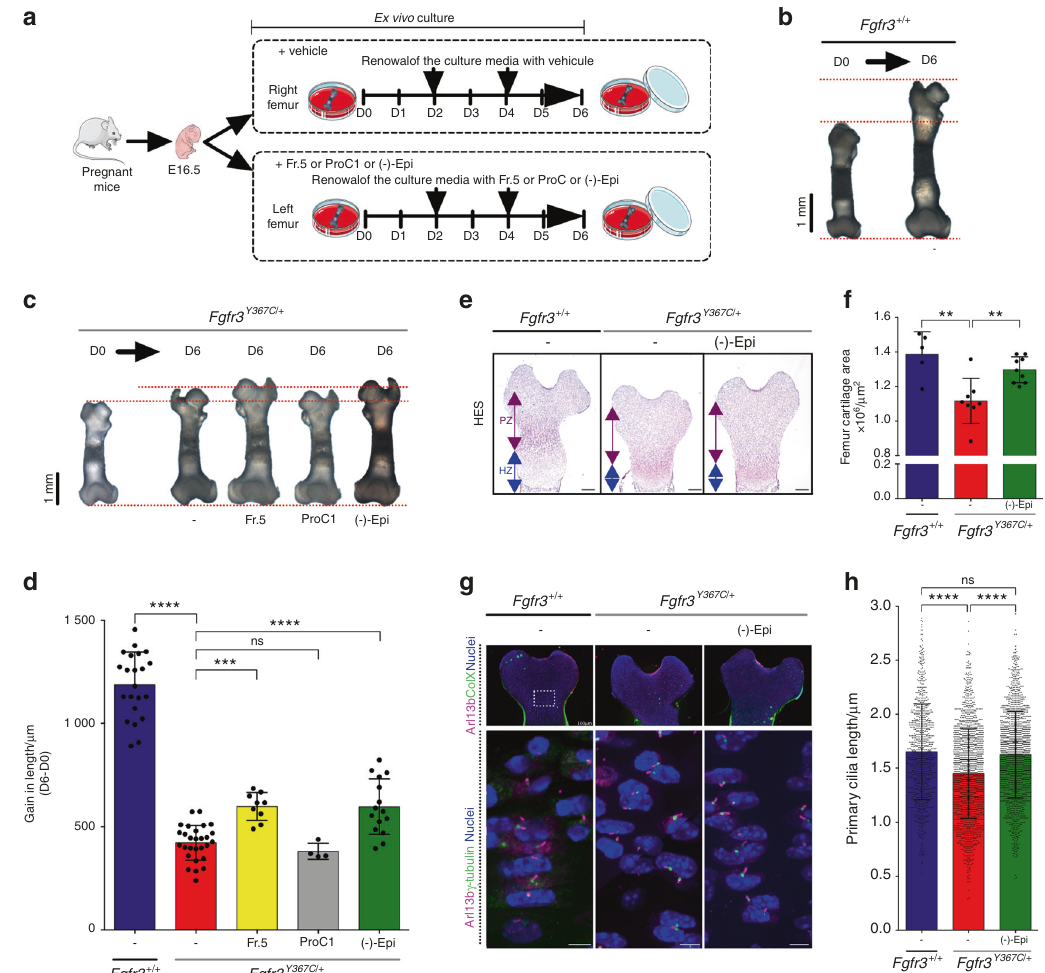
Fig. 3 (-)-Epicatechin increases ex vivo Fgfr3 Y367C/ + femur growth through primary cilia elongation. a Sequential representation of the ex vivo culture of femurs isolated from mouse embryos (E16.5). b Representative images of E16.5 Fgfr3 + / + femurs in ex vivo culture for 0 (D0) and 6 (D6) days. c Representative images of E16.5 Fgfr3 Y367C/ + femurs in ex vivo culture for 0 (D0) and 6 (D6) days exposed (or not) to Theobroma cacao fraction 5, procyanidin C1 or (-)-epicatechin. d Graphical representation of the gain in length of the ex vivo E16.5 Fgfr3 + / + and Fgfr3 Y367C/ + femurs after exposure (or not) to Theobroma cacao fraction 5, procyanidin C1 or (-)-epicatechin ( n = 15). e Representative images of HES- stained immunostained embryonic distal femurs. Scale bars: 200 μ m. PZ proliferative zone, HZ hypertrophic zone. f Graphical representation of the femur growth plate area in E16.5 Fgfr3 + / + ( n = 5) and Fgfr3 Y367C/ + femurs in the presence ( n = 8) or absence ( n = 7) of (-)-epicatechin. g Representative confocal image of the primary cilium immunolabeled with Arl13b (magenta), type X collagen or γ -tubulin (green), and DAPI (blue) localized in the control and Fgfr3 Y367C/ + femurs at Day 6. h Graphical representation of the primary cilium length in the chondrocytes from femur cultures at Day 6 from Fgfr3 + / + ( n = 917) and Fgfr3 Y367C/ + femurs exposed ( n = 1 667) or not ( n = 1 575) to (-)-epicatechin. Data are presented as the mean ± SD. ns not signi fi cant; *P < 0.05; **P < 0.01; * **P < 0.001; ****P < 0.000 1 by two-tailed, unpaired t test maintain healthy cartilage. The MAPK pathway (including p38 and plates was reported, as Fgfr3 mutation induces cell cycle exit and ERK1/2) affects Sox9 transcription, chondrocyte differentiation, promotes abnormal chondrocyte differentiation. 22 As previously and cartilage matrix synthesis. 32 Sox9, along with several other observed, 22 we noted that PCNA was overexpressed in the Fgfr3 Y367C/ + cartilage growth plate (3.02% ± 1.45% of the PCNA transcription factors, could also be regulated by p38, and elevated levels of phosphorylated p38 promote hypertrophic chondrocyte recovery surface) relative to the control (1.12% ± 0.79%) (Fig. 4e, differentiation. 33 Here, we observed that abnormal activation of f). Here, we found that PCNA expression levels were lower in (-)-epicatechin-treated Fgfr3 Y367C/ + femurs (1.20% ± 0.99% vs. FGFR3 signaling promotes abnormally high Sox9 expression (as previously described 34,35 ) and p38 and ERK1/2 phosphorylation 3.02% ± 1.45%) (Fig. 4f). Treatment with (-)-epicatechin for 6 days countered the abnormally high expression of PCNA, indicating levels in the growth plates of the cartilage of the femur explants. that (-)-epicatechin normalizes chondrocyte proliferation block- Interestingly, treatment with (-)-epicatechin was associated with ade and promotes chondrocyte maturation in Fgfr3 Y367C/ + lower levels of Sox9, phosphorylated p38 and ERK1/2 in the Fgfr3 Y367C/ + femur growth plate (Supplementary Fig. 8a – c). Overall, femurs. We also hypothesized that (-)-epicatechin treatment could these proof-of-principle experiments showed that (-)-epicatechin stimulate chondrocyte differentiation in growth plate cartilage. modulates the activation of FGFR3 ’ s major downstream signaling Chondrocyte differentiation is driven by many genes required to pathways.